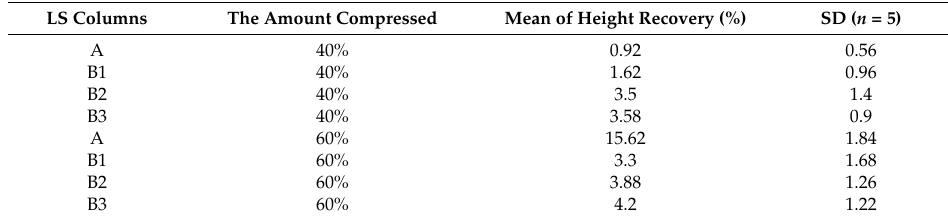
Figure 7. Mean of height recovery of LS columns. (A refers to LD LS columns with densities ranging from 15 to 35 kg/m 3 ; B1, B2, and B3 refer to HD LS columns with densities ranging from 15 to 35 kg/m 3 , 41 to 50 kg/m 3 , and 50 to 65 kg/m 3 , respectively. Table 2. The statistical analysis of height recovery of LS columns.